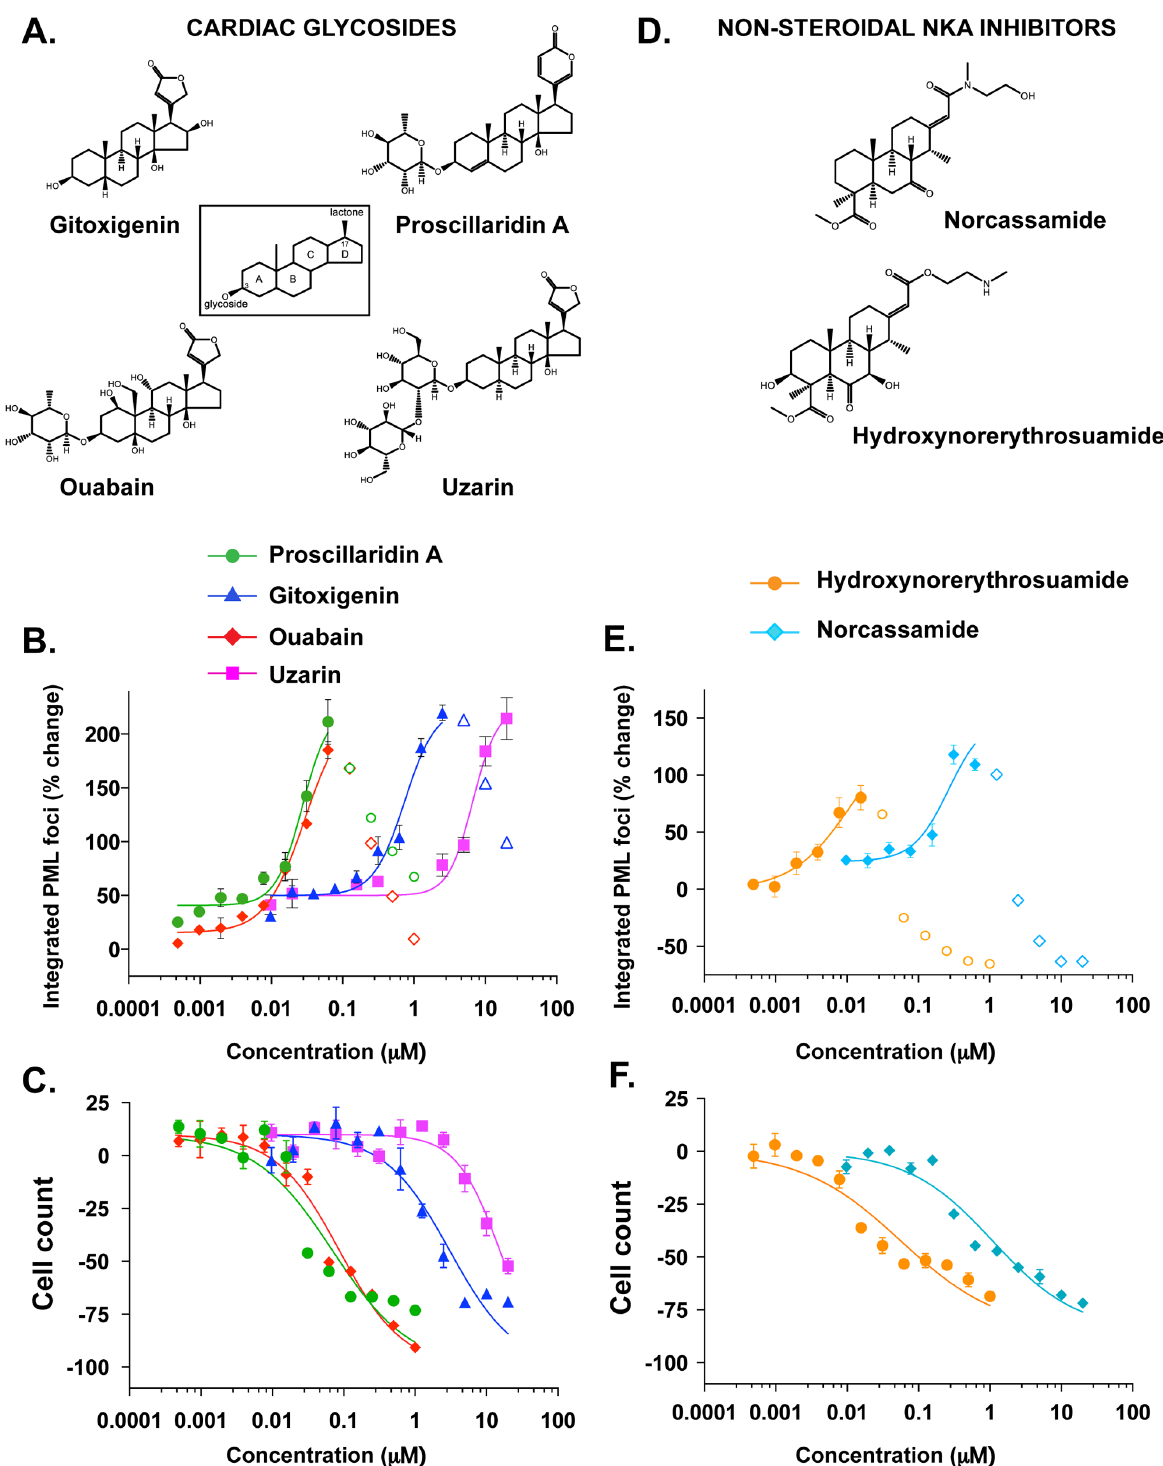
Fig 2. Diverse cardiac glycosides (CGs) and non-steroidal NKA inhibitors induce PML-NB formation. A, Structures of diverse cardiac glycosides (CGs). All CGs share a common structural motif comprised of a steroidal core adorned with an unsaturated lactone at ring position 17. CG lactone head- groups come in two varieties, unsaturated butyrolactones, such as gitoxigenin, ouabain and uzarin, and α -pyrones such as proscillaridin A. With the exception of the aglycones (e.g. gitoxigenin), the core is double substituted to contain a sugar moiety at ring position 3. B and C, HeLa cells were treated with increasing concentrations of CGs for 18h. PML NB formation and cell count was determined as described in Materials and Methods. D, Structures of non-